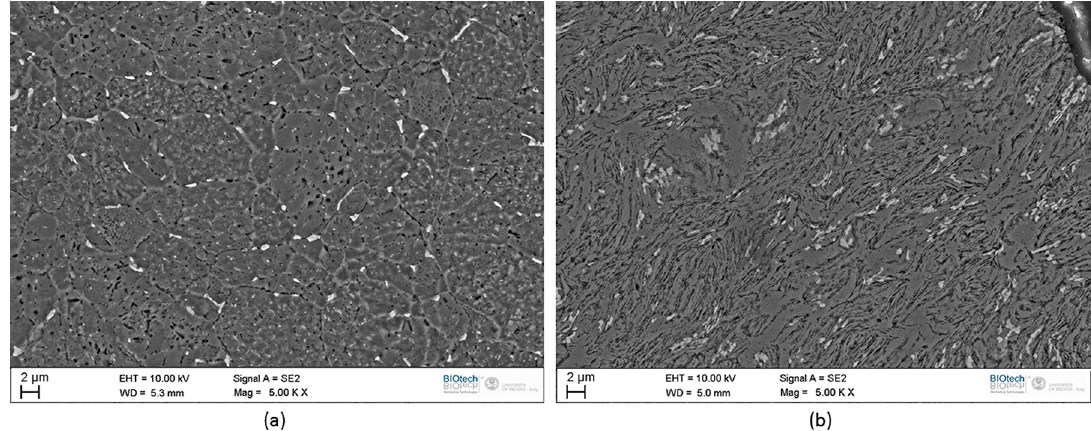
Figure 7. SEM images of (a) atomized and (b) 8 h milled samples after sintering.